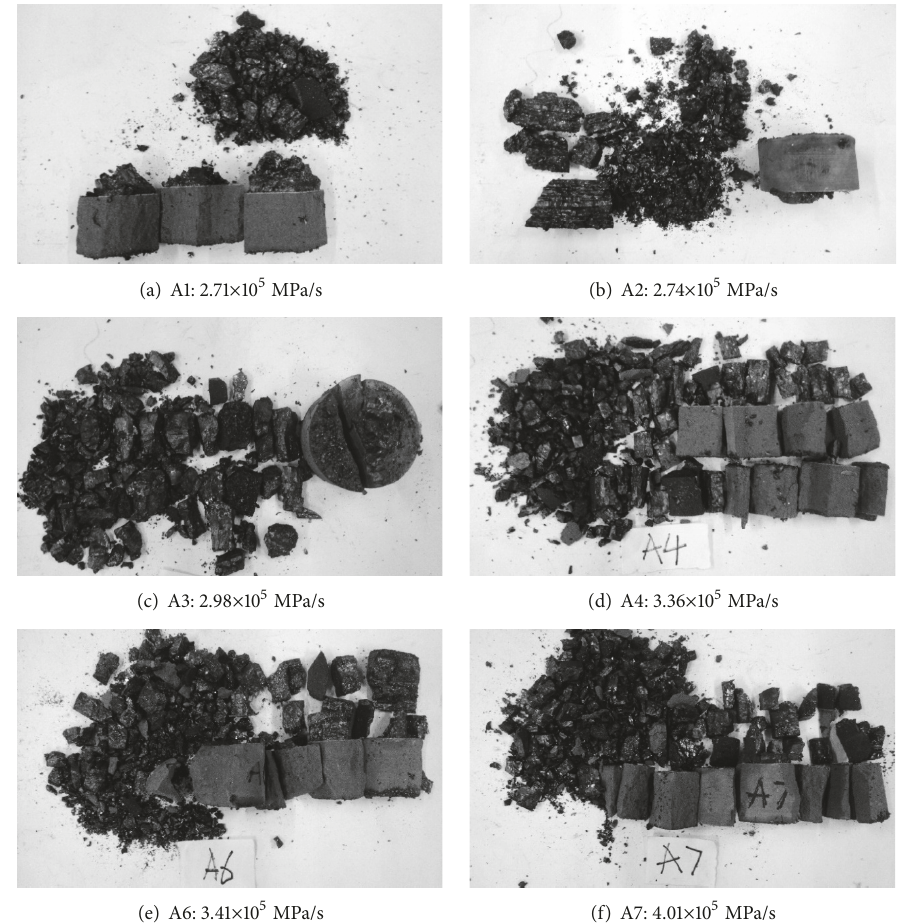
Figure 6: Failure modes of coal-rock combined body